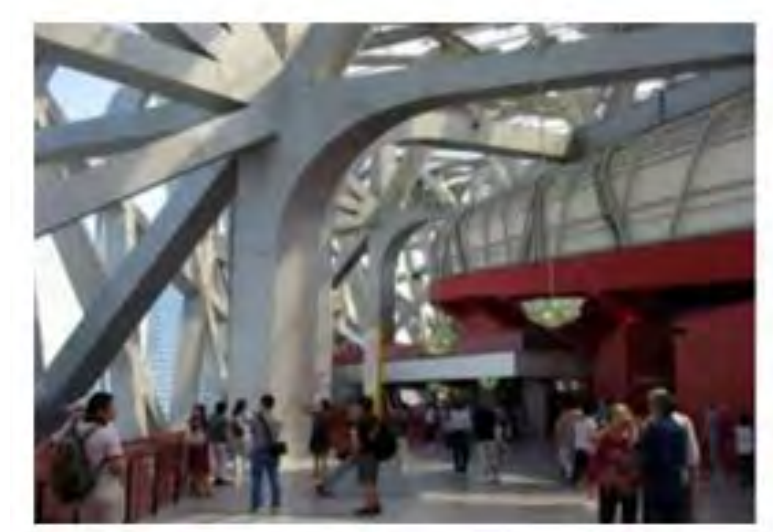
Figure 12. Bird’sNest Stadium n China, exterior.